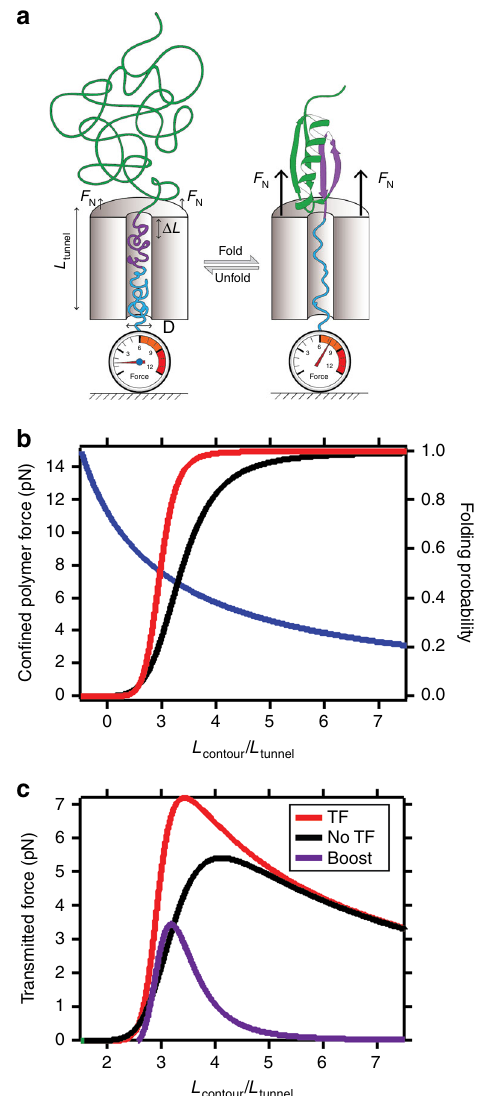
Fig. 4 Model for trigger factor-assisted force transmission through a molecular pore. a A polypeptide chain exiting a molecular tunnel is under some tension due to the con fi ned geometry ( left ). When the protein folds in the edge of the tunnel ( right ), it pulls out a fraction of the polypeptide in the channel ( purple fragment ), increasing the mechanical tension and hampering the folding transition. b When a polymer is con fi ned in a tube of fi xed length L tunnel is subject to an effective force, which depends on its contour length L contour . This force can be approximately modeled by a freely jointed chain (FJC) model, where the end-to-end distance is fi xed to L fi ned tunnel and the force depends on the length of the con polymer L contour ( blue line ). Accordingly, the folding probability with ( red ) and without ( black ) TF of a polypeptide chain in such scenario depends on L contour . c Protein folding generates shortening which increases the tension of the polymer, transmitting a force through the tunnel. We can estimate this expected force as the product between the force generated by the con fi ned polymer and the probability of folding at such length L contour . This is calculated with ( red ) and without ( black ) TF revealing that there is an optimal length of the con fi ned polymer, between 3 and 4 times the length of the tunnel. Shorter polymers would induce large tensions that would avoid protein folding, so the expected force is zero. Longer polymers would lead to small values of the expected force. In the optimal region, TF boosts the transmitted force